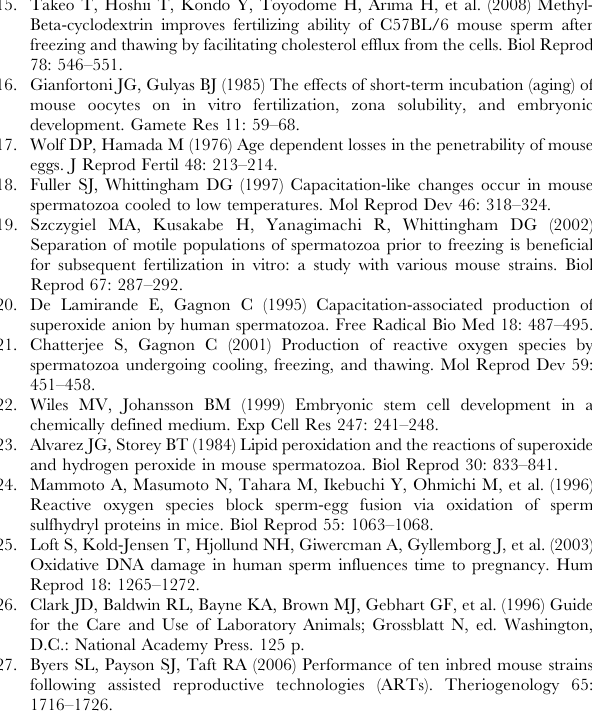
Table S2 Data set for freshly collected sperm and cryopreserved embryos. Table S3 Calibration parameters used with Hamilton Thorne IVOS computerized semen analyzer (Beverly, MA).